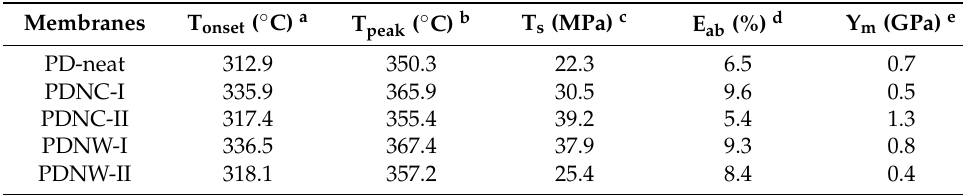
Figure 4. Thermogravimetric analyzer (TGA) and DTG curves of PD-neat, PDNC-I, PDNC-II, PDNW-I and PDNW-II membranes. Table 2. Thermal and mechanical data of membrane